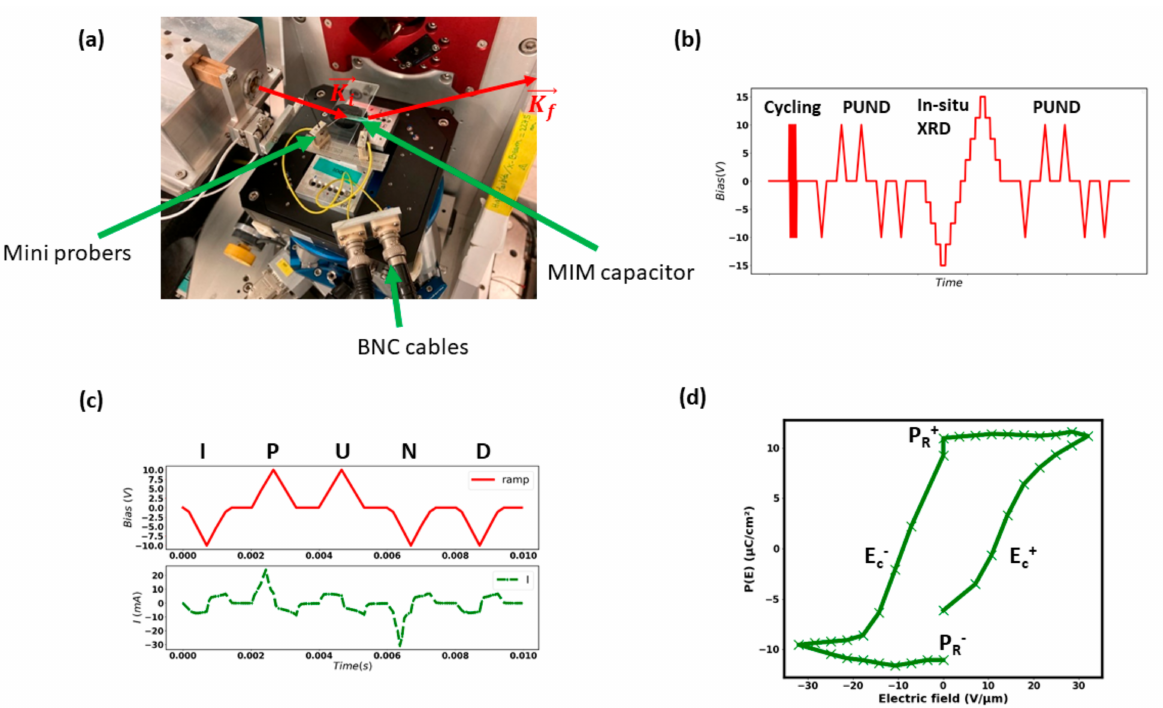
Figure 1. ( a ) The setup for the in situ biasing XRD experiment; ( b ) the experimental procedure; ( c ) the PUND waveform (red) and current response (green); and ( d ) the extract polarization loop from the PUND